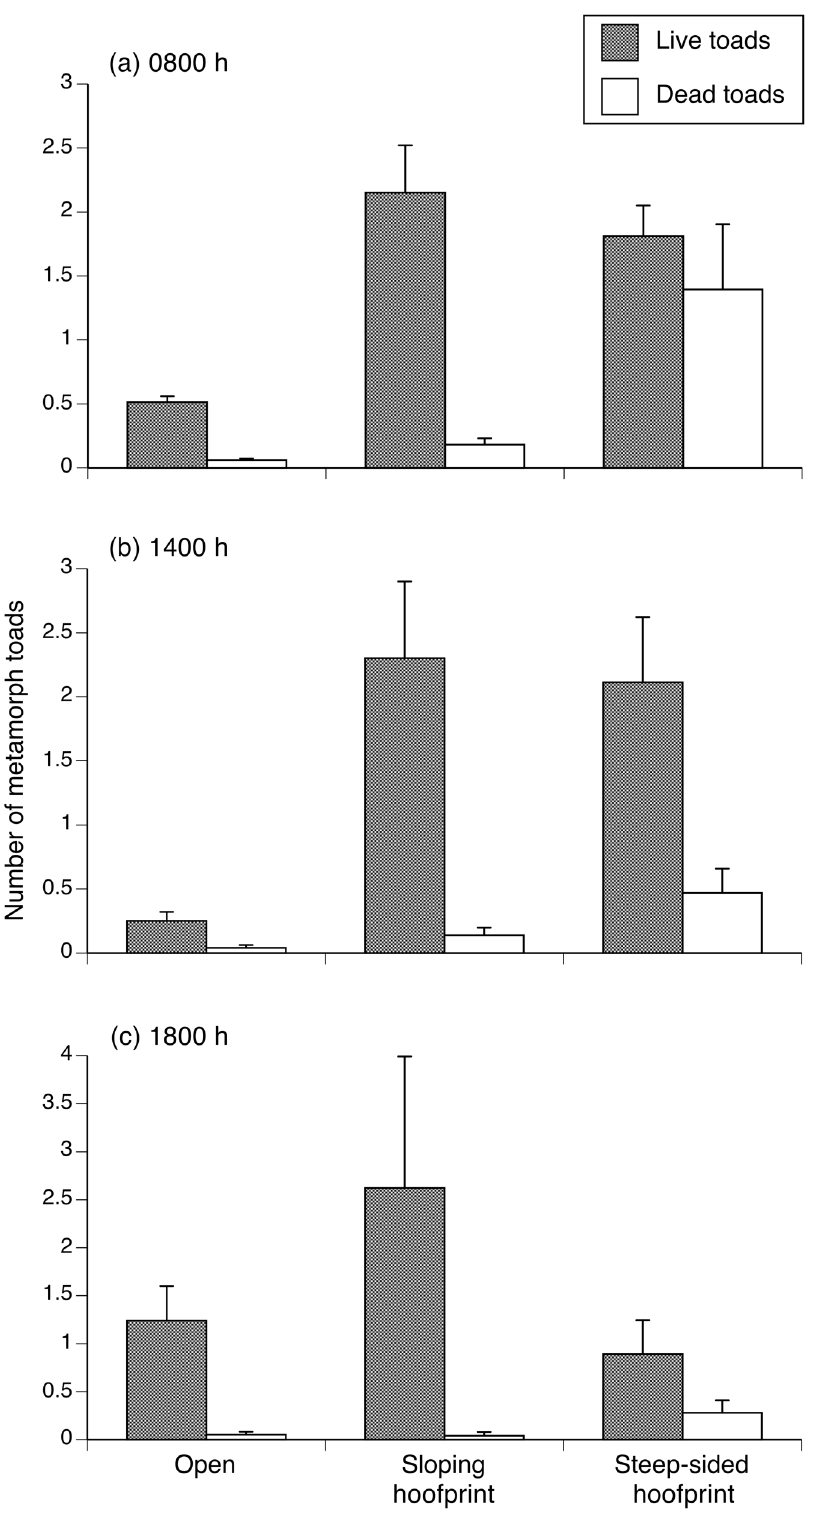
Figure 6. Number of toads (mean + 1 SE) found alive and dead (killed by meat ants) on open substrate and in hoofprints, during our field surveys. The panels show counts made in the morning (a), in the early afternoon (b), and in the late afternoon (c).